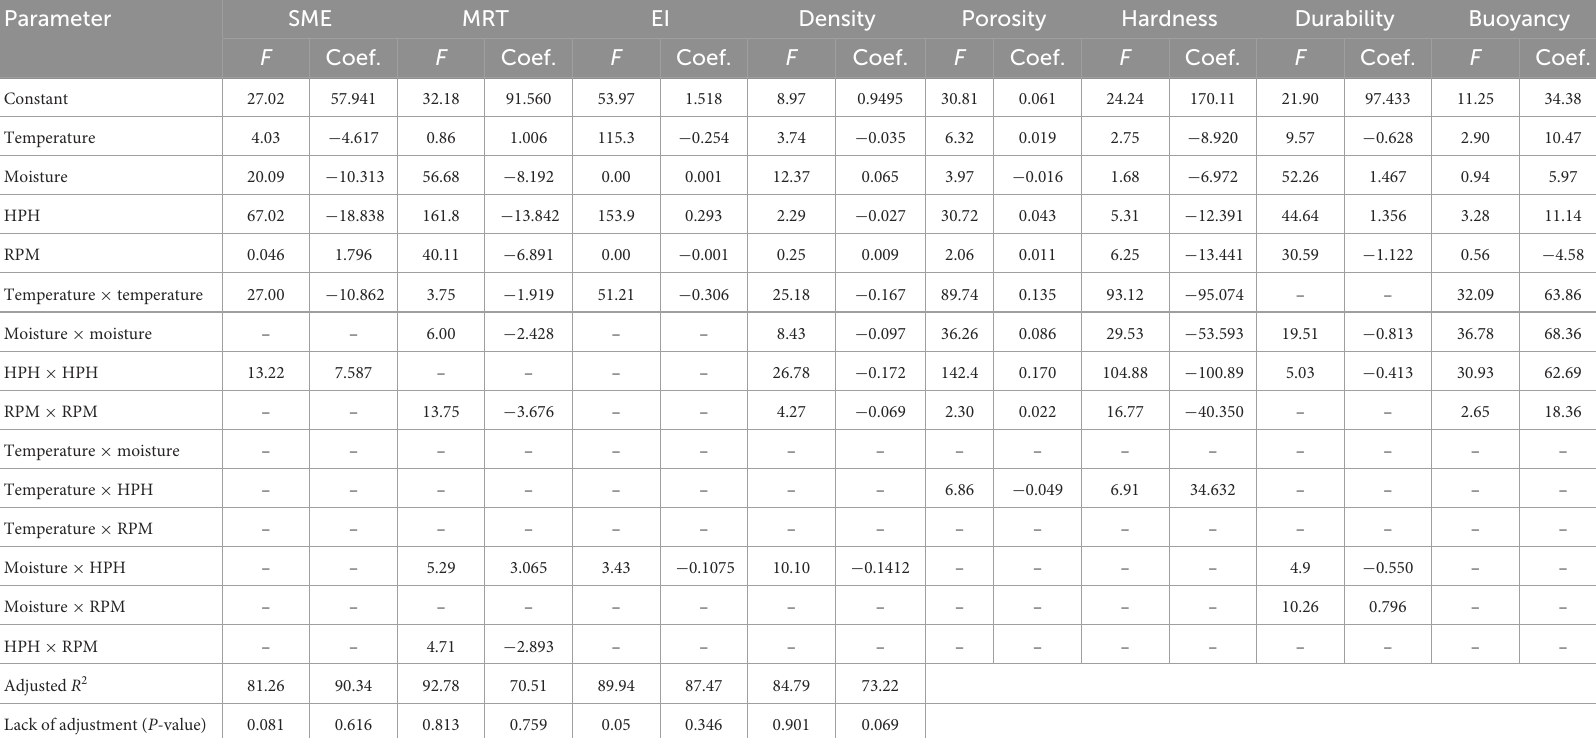
TABLE 4 Regression analysis of specific mechanical energy (SME), mean residence time (MRT), expansion index (EI), density, porosity, hardness, durability, and buoyancy of the obtained extruded feeds.